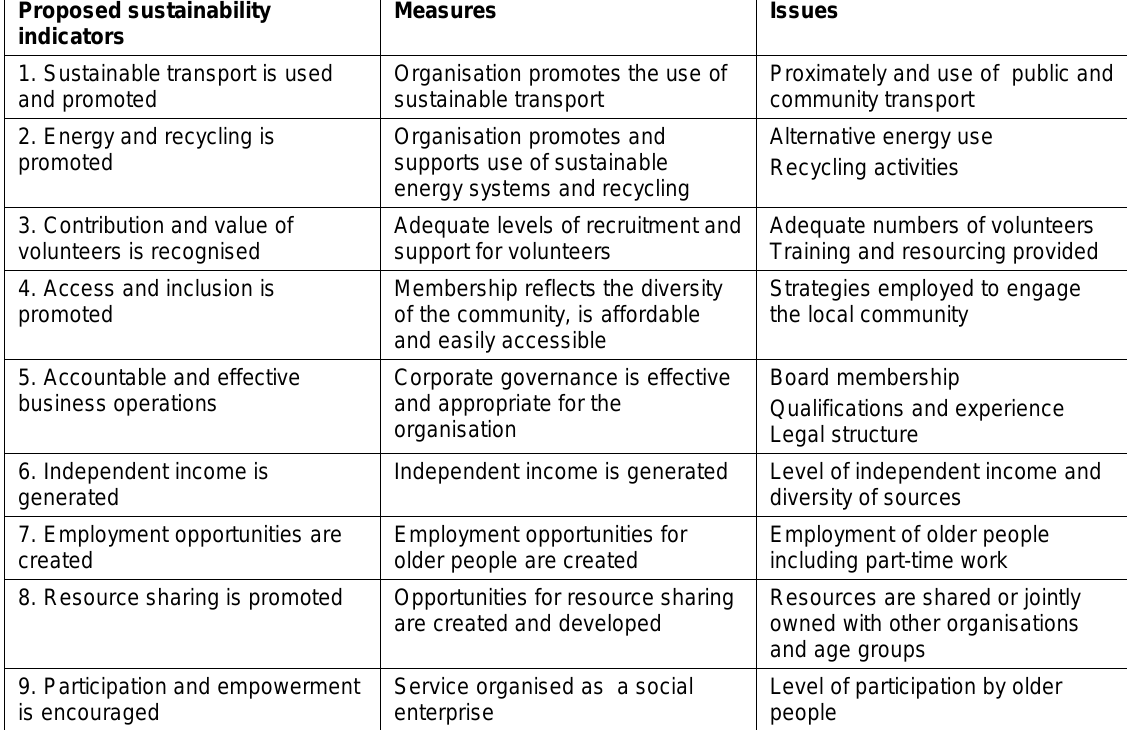
Table 2: Proposed sustainability indicators for